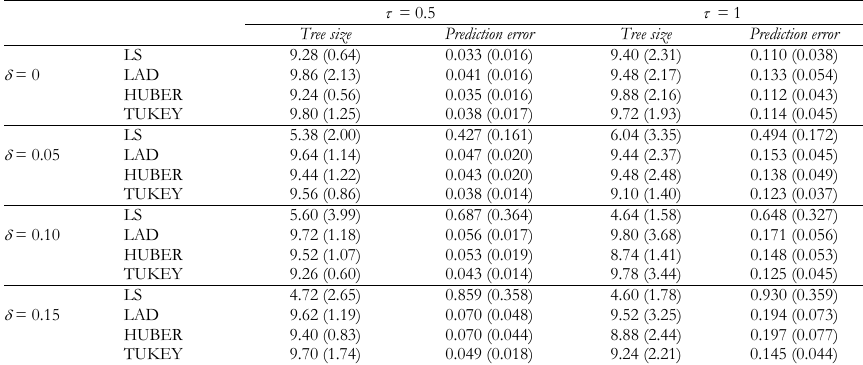
Mean and standard deviation (in brackets) of the tree sizes and the prediction errors over 50 replications